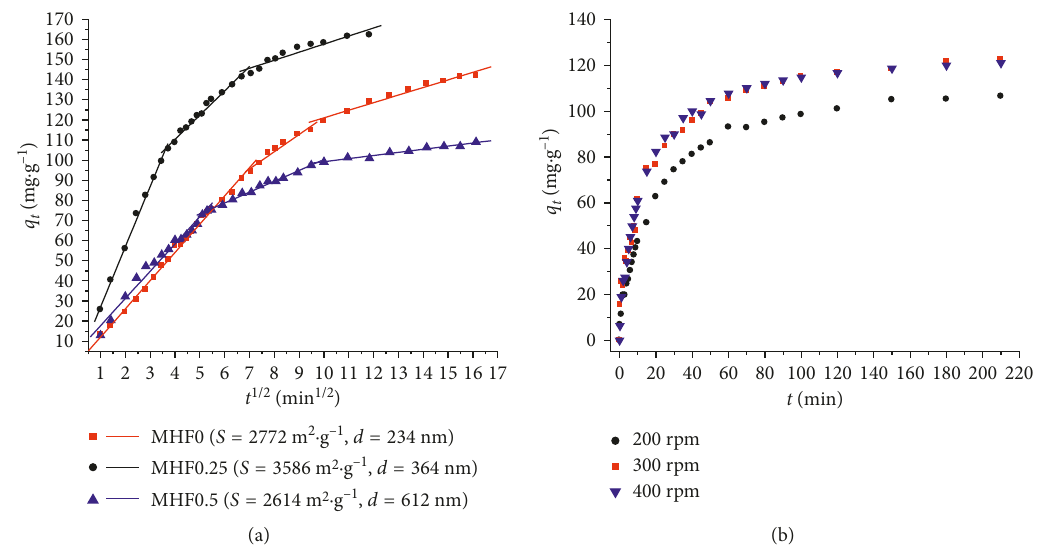
Figure 6: (a) Plots of the three-linear-segment regression of intraparticle diffusion model; (b) effect of stirring speed on the adsorption capacity of RDB on MIL-101.